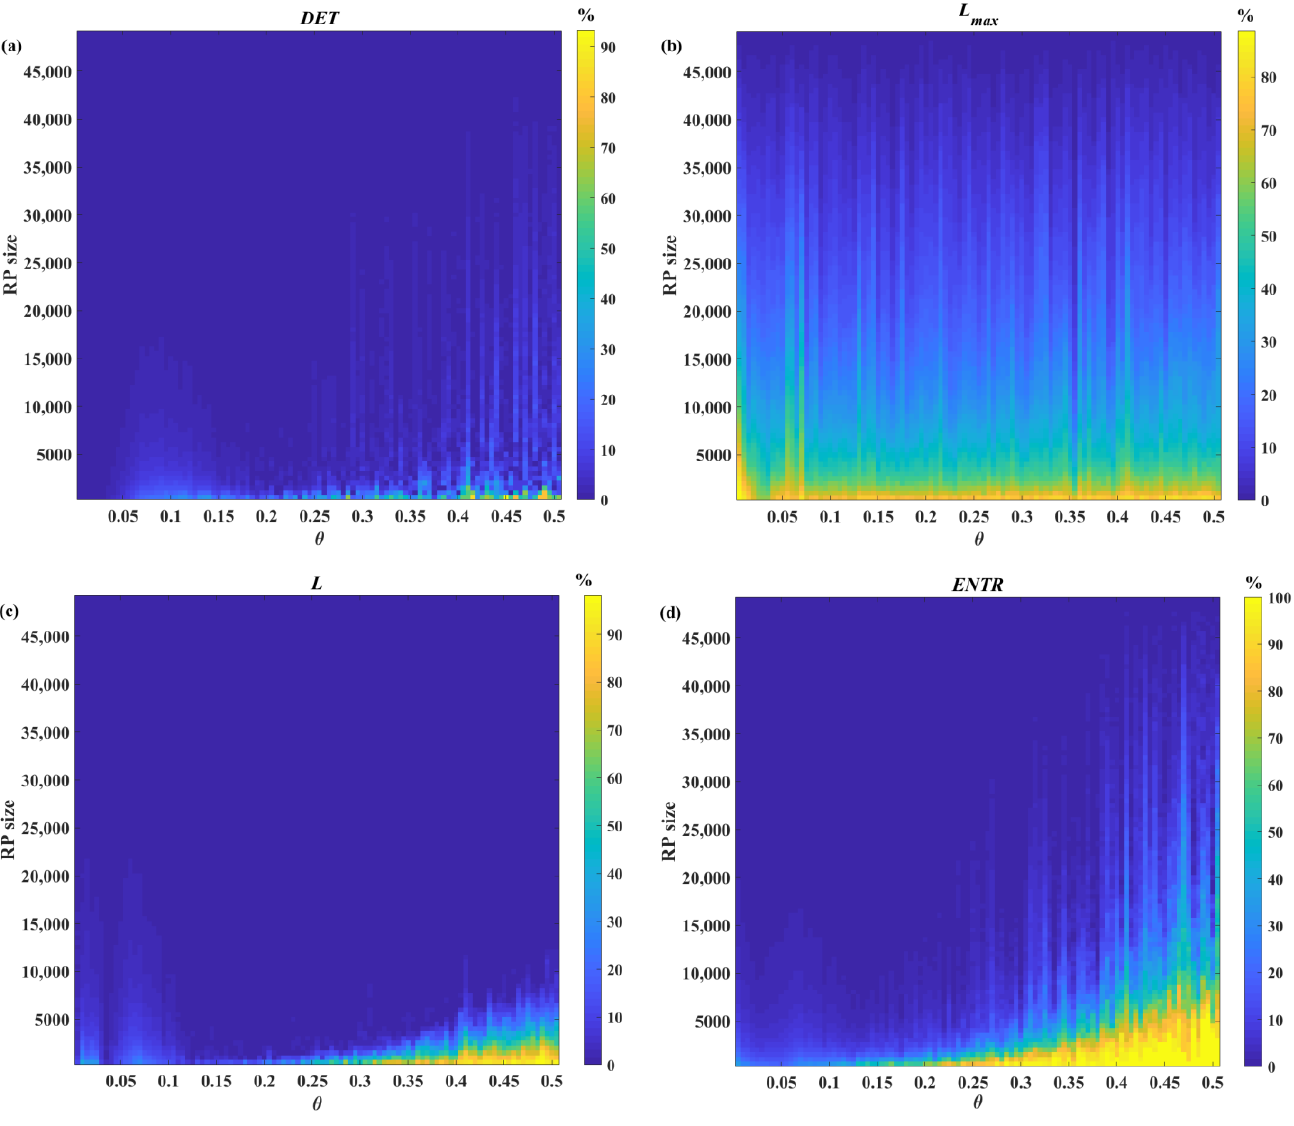
Figure 5. Relative error of the RQA features estimates as a function of length and noise level of Rössler time series: ( a ) determinism, ( b ) maximal diagonal line length, ( c ) average diagonal line length, and ( d ) entropy. Table 1. Values of determinism, maximal diagonal line length, average diagonal line length, and entropy obtained for long Rössler’s x time series for three different noise